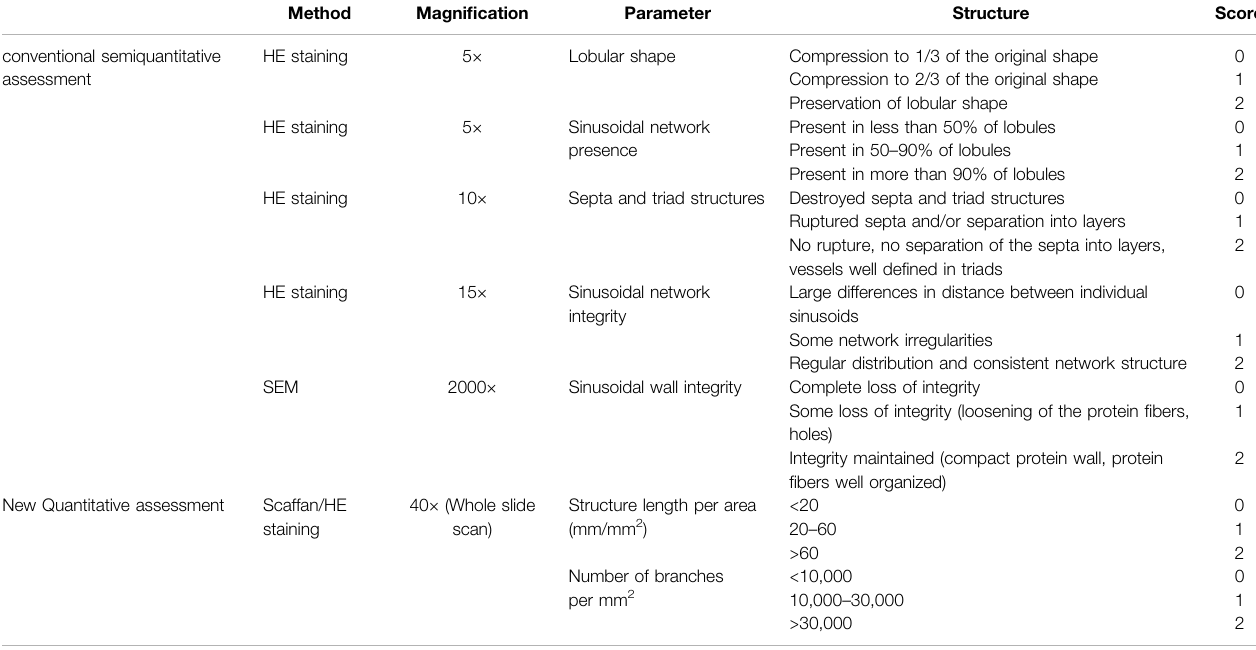
TABLE 3 | Morphological multi-scale evaluation